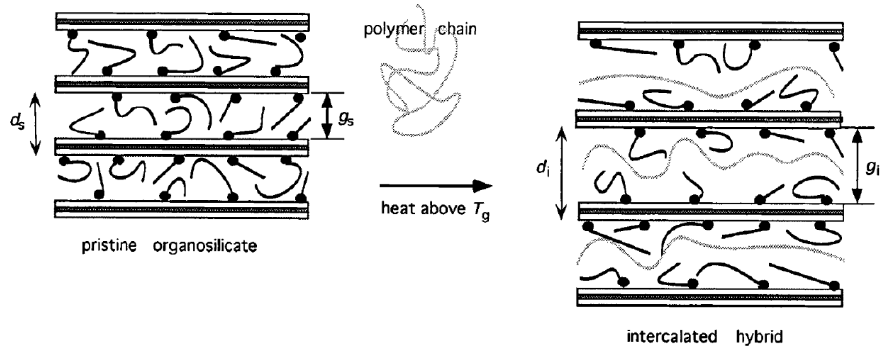
Figure 4. Melt intercalation of polymer chains into layered silicate. The temperature used to melt the polymer is its T g if the polymer is amorphous or its T m if it is semi-crystalline. g is the spacing between silicate layers (g s < g i ) and d is the silicate inter-layer distance. Reprinted with permission of Journal of Polymer Science Part B: Polymer Physics 1996, 34 (8), 1443–1449 [35].